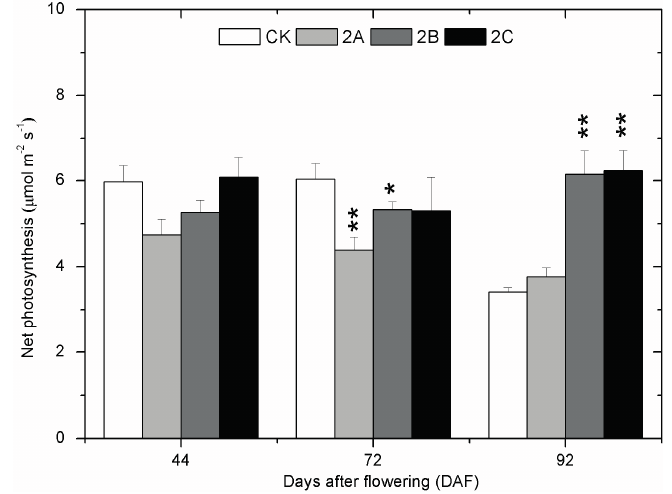
Figure 1. Net photosynthetic rate (Pn) of leaves at three berry developmental stages in 2013. Veraison stage corresponds to 61 DAF. The asterisk represents the Pn in the zinc treatment group is significantly different than the control group at 1% level (for two asterisks) and 5% level (for one asterisk), respectively. Statistically significant difference between the Zn-treated groups and the control was calculated by Least-significant difference (LSD) analysis. The bars indicate the mean of three values and their standard